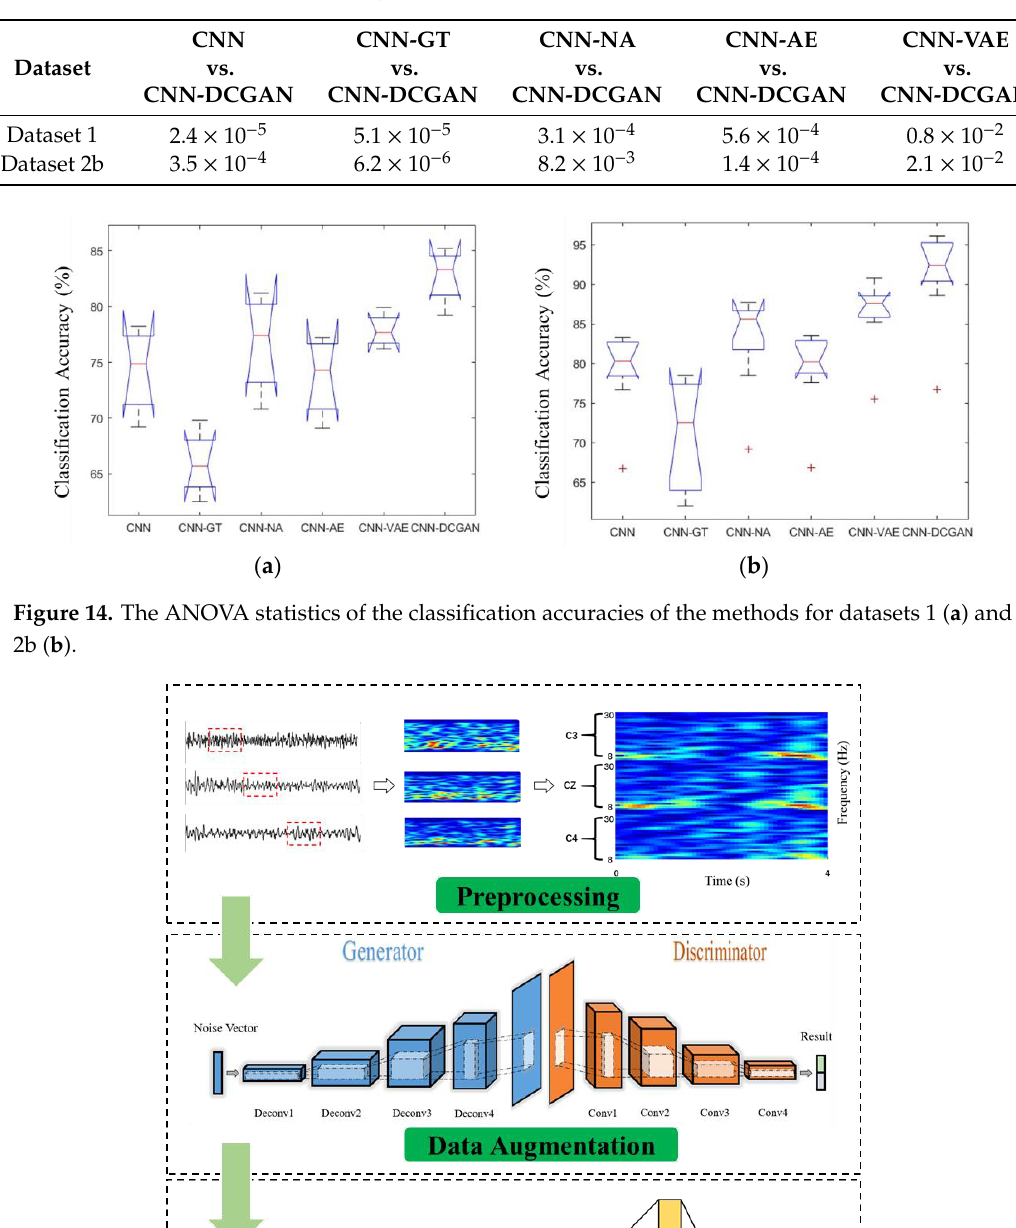
Table 11. The classification performance of different methods for the BCI competition IV dataset 2b.